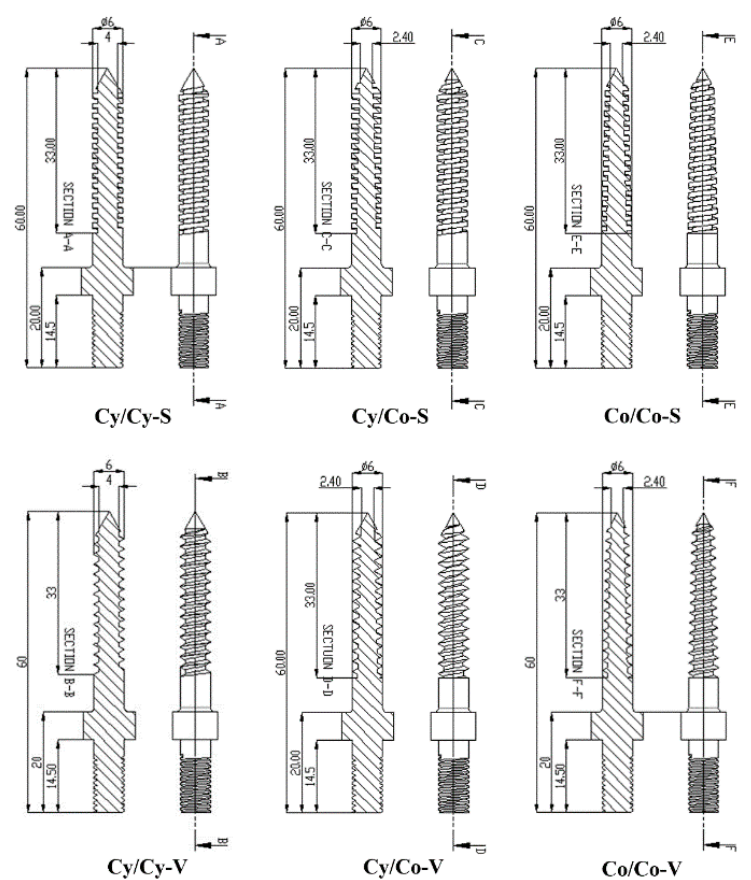
Figure 1. Schematic drawings showing six types of pedicle screws. The outer/inner projection of the screws differed mainly in the taper of the major and minor diameter from the hub to the tip. The Cy/Cy screws maintained a constant outer/inner diameter (6.0 mm/4.0 mm) from hub to tip; the Cy/Co screws maintained a constant outer diameter (6.0 mm) but had a core diameter that tapered by 40%, from 4.0 mm at the hub to 2.4 mm at the tip; and both the outer and core diameters of the Co/Co screws tapered by 40% (from 6.0 to 3.6 mm and 4.0 to 2.4 mm for the outer and core diameters, respectively). For all screw types, the thread pitch was 2.4 mm.